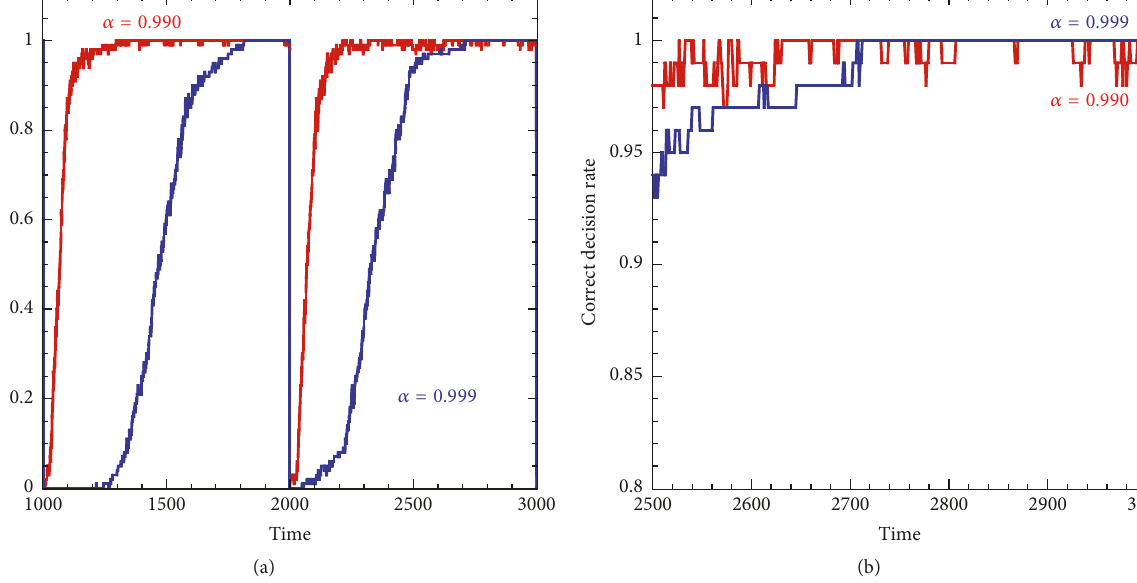
Figure 4: (a) Temporal evolutions of the correct decision rate (CDR) for different values of the memory parameter [ 𝛼 = 0.990 (red line) and 0.999 (blue line)] and (b) enlarged view of